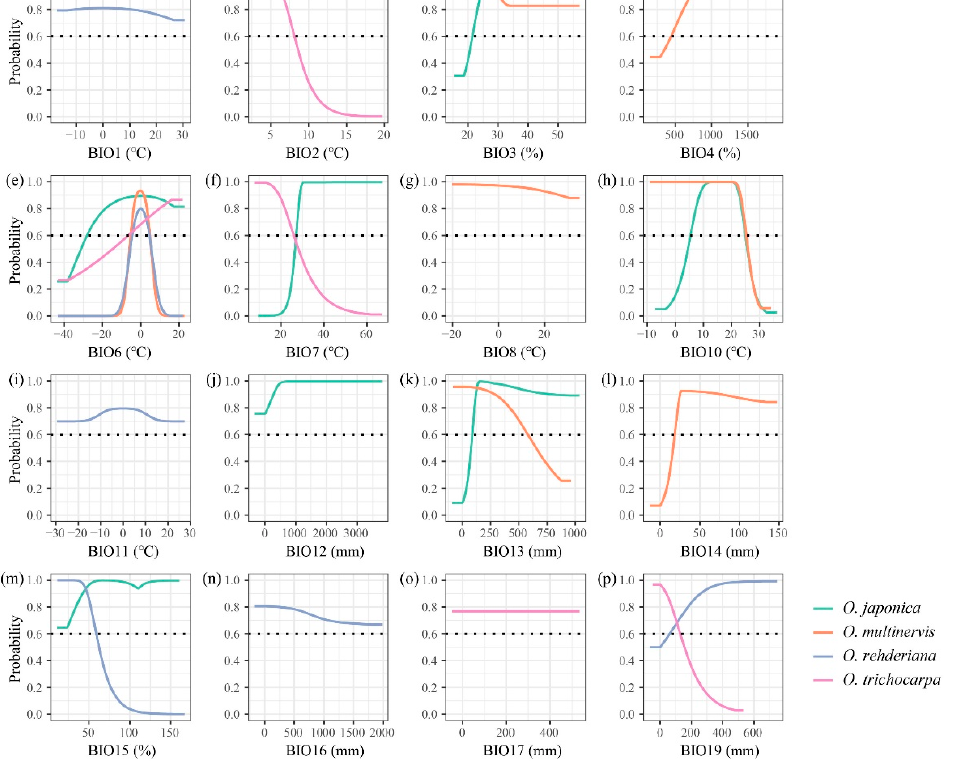
Figure A1. Response curves of four Ostrya species, i.e., O. japonica , O. multinervis , O. rehderiana , and O. trichocarpa , presence probability affected by climate variables, i.e., BIO1 ( a ), BIO2 ( b ), BIO3 ( c ), BIO4 ( d ), BIO6 ( e ), BIO7 ( f ), BIO8 ( g ), BIO10 ( h ), BIO11 ( i ), BIO12 ( j ), BIO13 ( k ), BIO14 ( l ), BIO15 ( m ), BIO16 ( n ), BIO17 ( o ), and BIO19 ( p ). See Table 2 for the meaning of each climatic variable. The black dotted line represents that the probability of species existing is 0.6, species would archive high potential adaptation above this line.